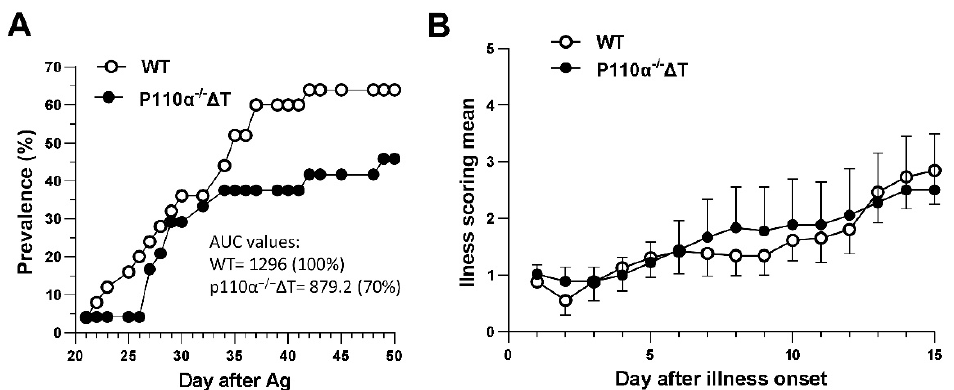
Figure 1. Collagen-induced arthritis in p110 α − / − ∆ T mice. Mice were immunized with type II collagen in complete Freund’s adjuvant. ( A ) Time course of prevalence of arthritis in the mice referred to day post-antigen administration. Area under the curve (AUC) values and the percent of ill mice referred to the control group are indicated. ( B ) The clinical score after the day of illness onset was recorded for 15 days. Data (mean ± SEM) from three experiments with a total n = 24 for control group (WT, white symbols) and n = 25 for p110 α − / − ∆ T mice (black symbols) are shown.